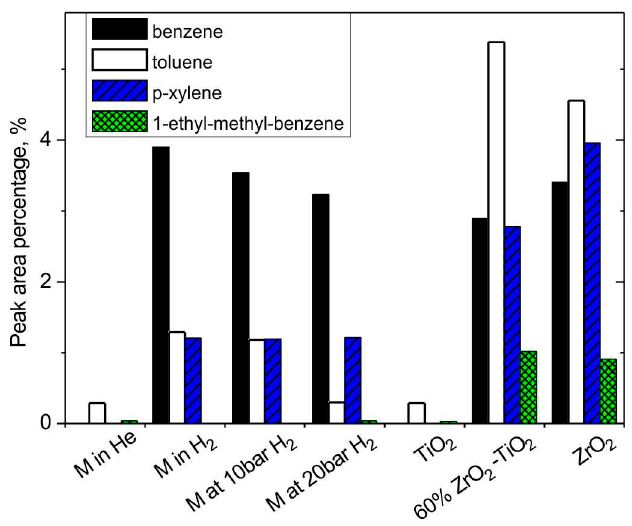
Figure 7. The peak area percentage of aromatic hydrocarbons.